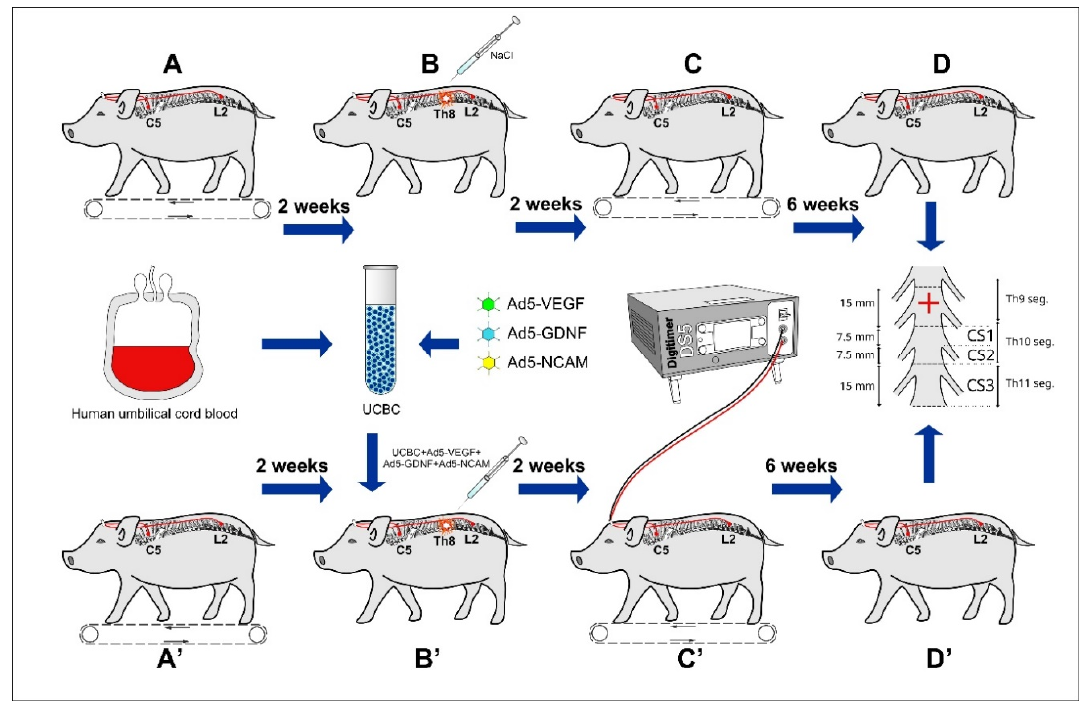
Figure 1. Study design. Upper panel: ( A ) Implantation of stimulating electrodes followed by recovery and training of animals to walk on a treadmill. ( B ) Spinal contusion followed by intrathecal administration of saline (0.9% NaCl) 4 h after injury. ( C ) Training on a treadmill every 2nd day started 2 weeks after injury. ( D ) Termination of the experiment at 60 days after injury. The caudal part of the spinal cord relative to the epicenter of injury (red cross) was divided into three segments (CS1, CS2, and CS3) for histological and molecular studies. Low panel: ( A ’) Implantation of stimulating electrodes followed by recovery and training of animals to walk on a treadmill. ( B ’) Spinal contusion followed by intrathecal administration of gene modified umbilical cord blood mononuclear cells (UCBC) 4 h after injury. ( C ’) Epidural electrical stimulation (EES) every 2nd day combined with training on a treadmill started 2 weeks after injury. ( D ’) Termination of the experiment at 60 days after injury and harvesting of the spinal cords for investigation. Intact healthy animals (not shown) were used to collect basic behavioral, electrophysiological, and histological data for comparative analysis.